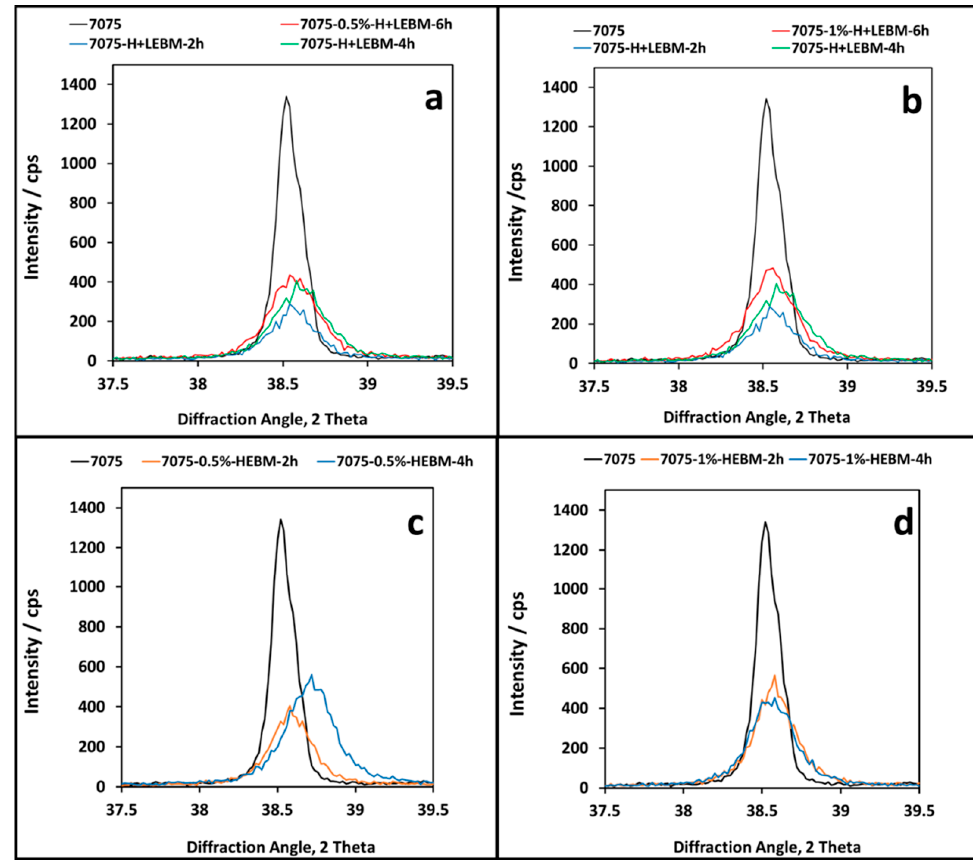
Figure 13. XRD patterns for AA7075-MWCNT powders with different MWCNT percentages milled following different routes. Broadening and shift in the Al (111) peak is shown for: ( a ) H + LEBM and 0.5 wt.% MWCNTs; ( b ) H + LEBM and 1 wt.% MWCNTs; ( c ) HEBM and 0.5 wt.% MWCNTs; ( d ) HEBM and 1 wt.%